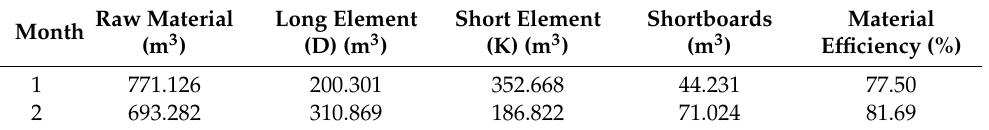
Table 6. The results of sawn timber prefabrication for furniture elements according to the variant “Ap”. Raw Material Month (m 3 )